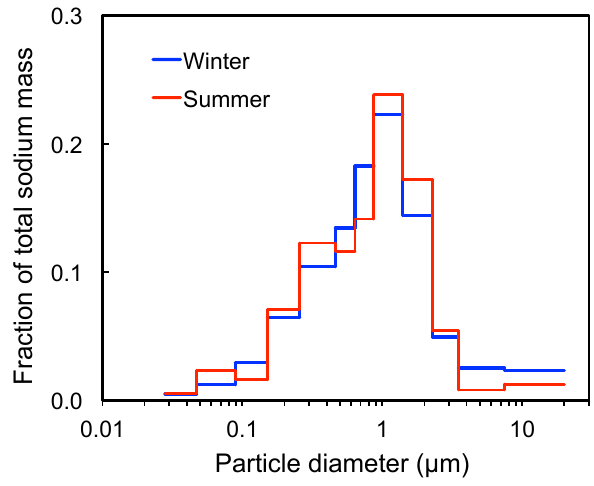
Figure 12. Mean size-segregated mass of sodium (expressed as fraction of the total sodium mass) in winter (May–October, 55 sam- ples) and summer (November–April, 40